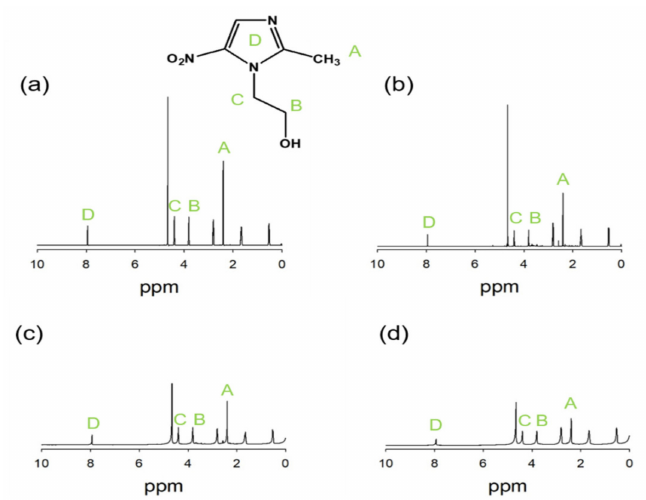
Figure 2. NMR spectra of MD ( a ) 0 kGy ( b ) 25 kGy, ( c ) 50 kGy, and ( d ) 75 kGy.